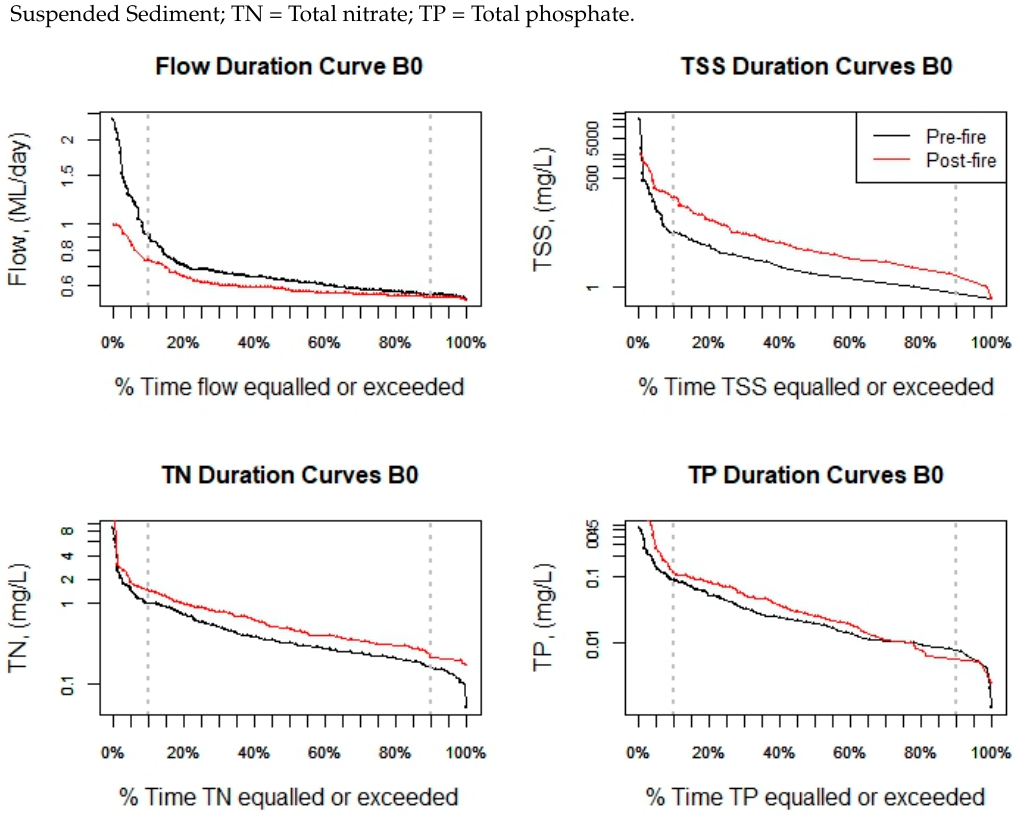
Figure 5. Duration curves for catchment B0 Abbreviations: B = Burnt; Q = Flow; TSS = Total Suspended Sediment; TN = Total nitrate; TP = Total phosphate.